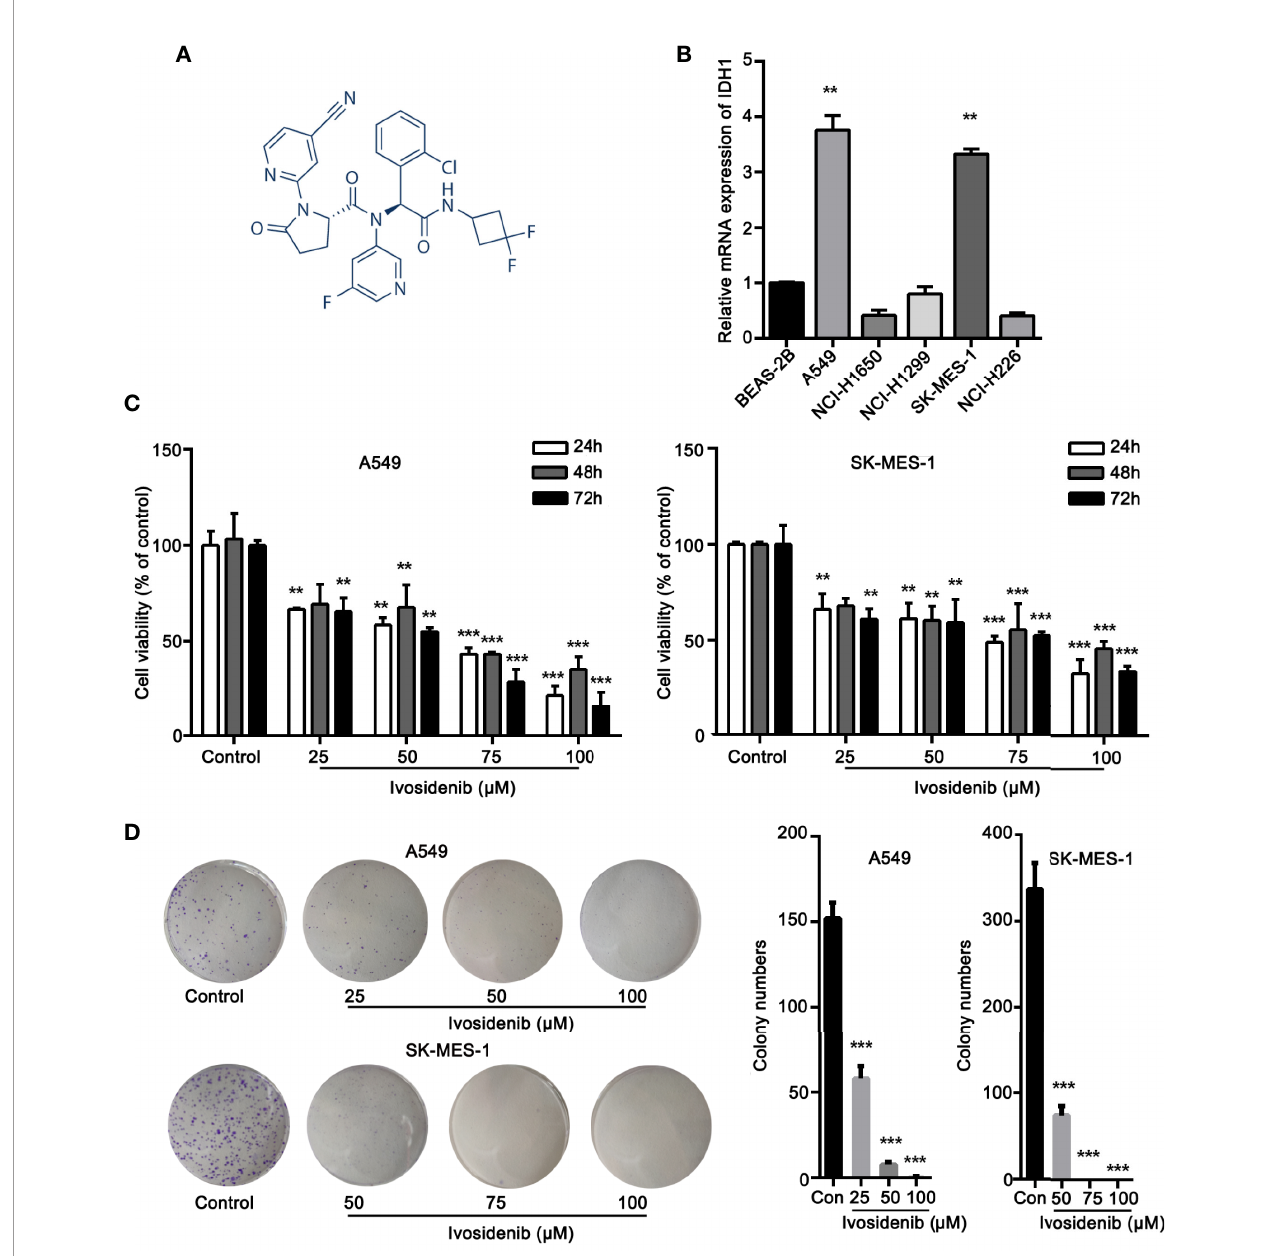
FIGURE 1 | Ivosidenib inhibits the proliferation of NSCLC cells. (A) Chemical structure of ivosidenib. (B) IDH1 expression in NSCLC and BEAS-2B cell lines. (C) A549 and SK-MES-1 cells were treated with various concentrations of ivosidenib for 24, 48, and 72 h, and proliferation was measured using the MTT assay. Data are expressed as mean ± SD of three separate experiments. (D) Colony-formation assay (representative wells are presented). ** p < 0.01, *** p < 0.001 vs.